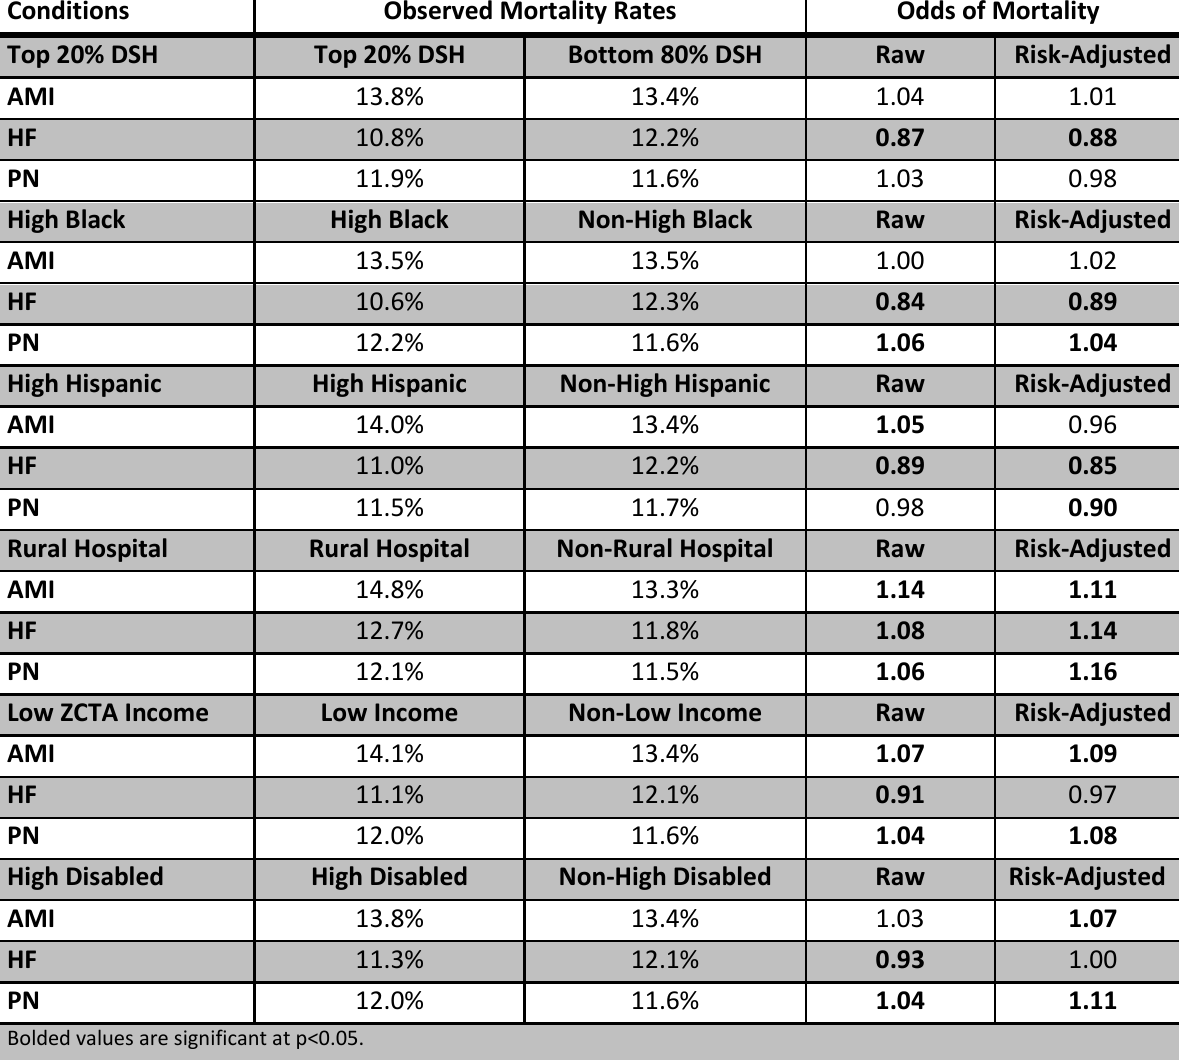
Table 7.7. Hospital Social Risk and Condition-Specific Mortality Rates (AMI, HF,